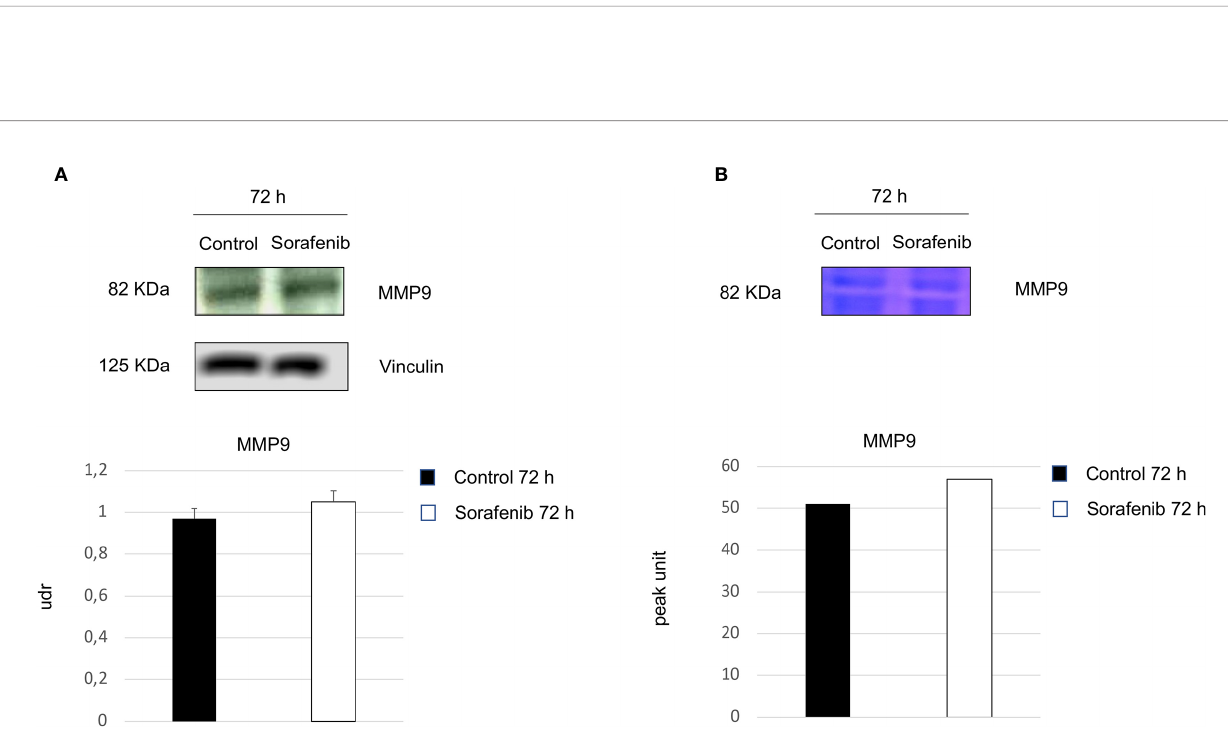
FIGURE 6 | Role of sorafenib treatment in tumor invasiveness. MMP9 protein levels were detected by Western blot (A) . Zymographyc analysis con fi rmed the protein activity (B) . Below are shown bar graphs expressing the protein expression of MMP9 (on the left) and MMP9 activity (on the right). The results reported in the graph represent the mean values ± standard error. Densitometry summarizes the results obtained in three independent